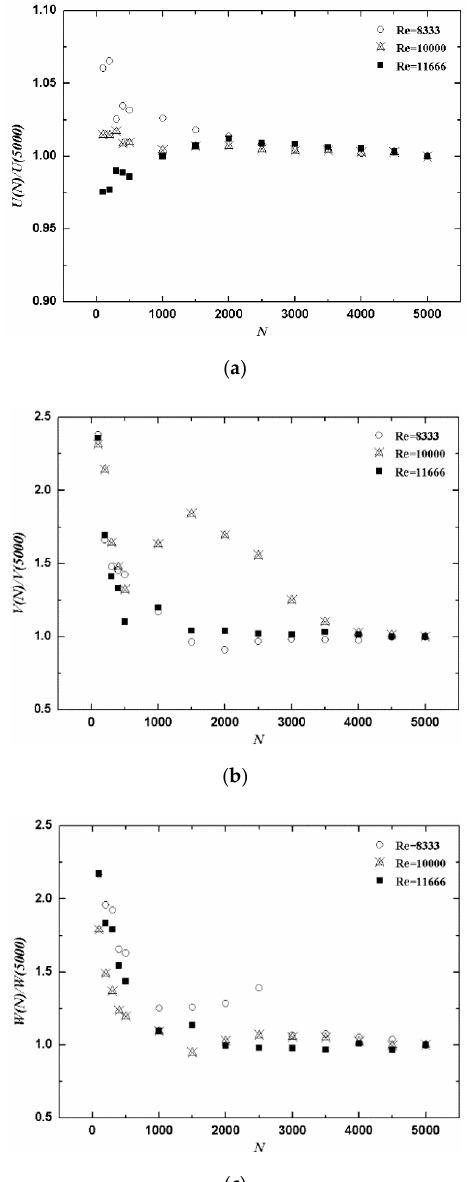
Figure 3. Convergence test for the experimental data for three different Reynolds numbers (Re) of 8333, 10,000, and 11,666: ( a ) x -axial mean velocity ( U ) varies with the number of instantaneous image pairs ( N ), ( b ) y -axial mean velocity ( V ) varies with the number of instantaneous image pairs ( N ), and ( c ) z -axial mean velocity ( W ) varies with the number of instantaneous image pairs ( N ).